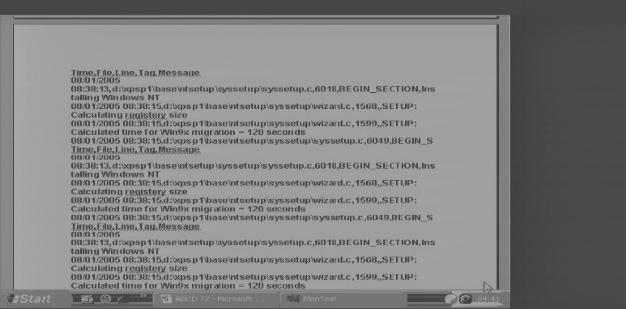
Figure 3. The reconstructed image (rasterized) in correct way, VGA interface signal as a source of reveal emission, 640 × 480/60 Hz mode, 62.5 MHz sampling rate, line length 1984.11007.